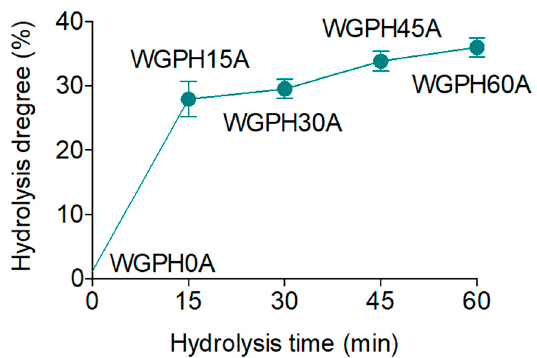
Figure 1. Time-course of Hydrolysis Degree (HD) of WGPC (WGPH0A) during hydrolysis with enzyme Alcalase at 15 (WGPH15A), 30 (WGPH30A), 45 (WGPH45A), and 60 (WGPH60A) min. All values are expressed as the percentage of peptide bonds cleaved, and are mean ± standard deviation of triplicates.